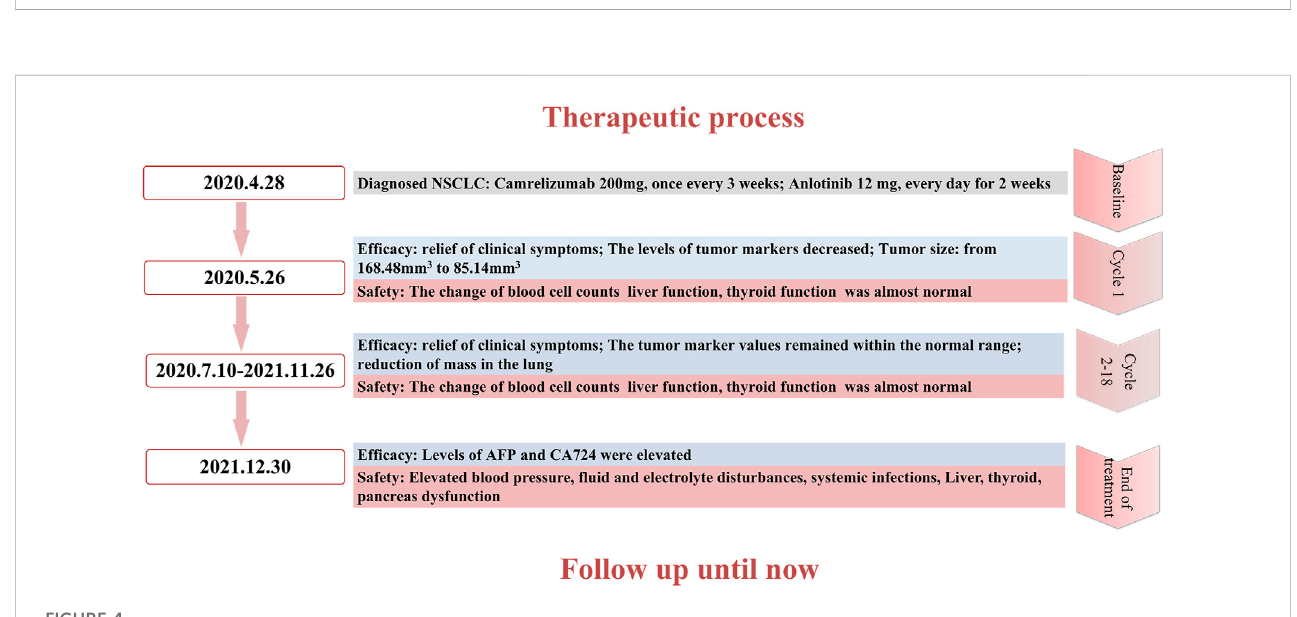
FIGURE 4 The whole therapeutic process including treatment strategy, ef fi cacy and side